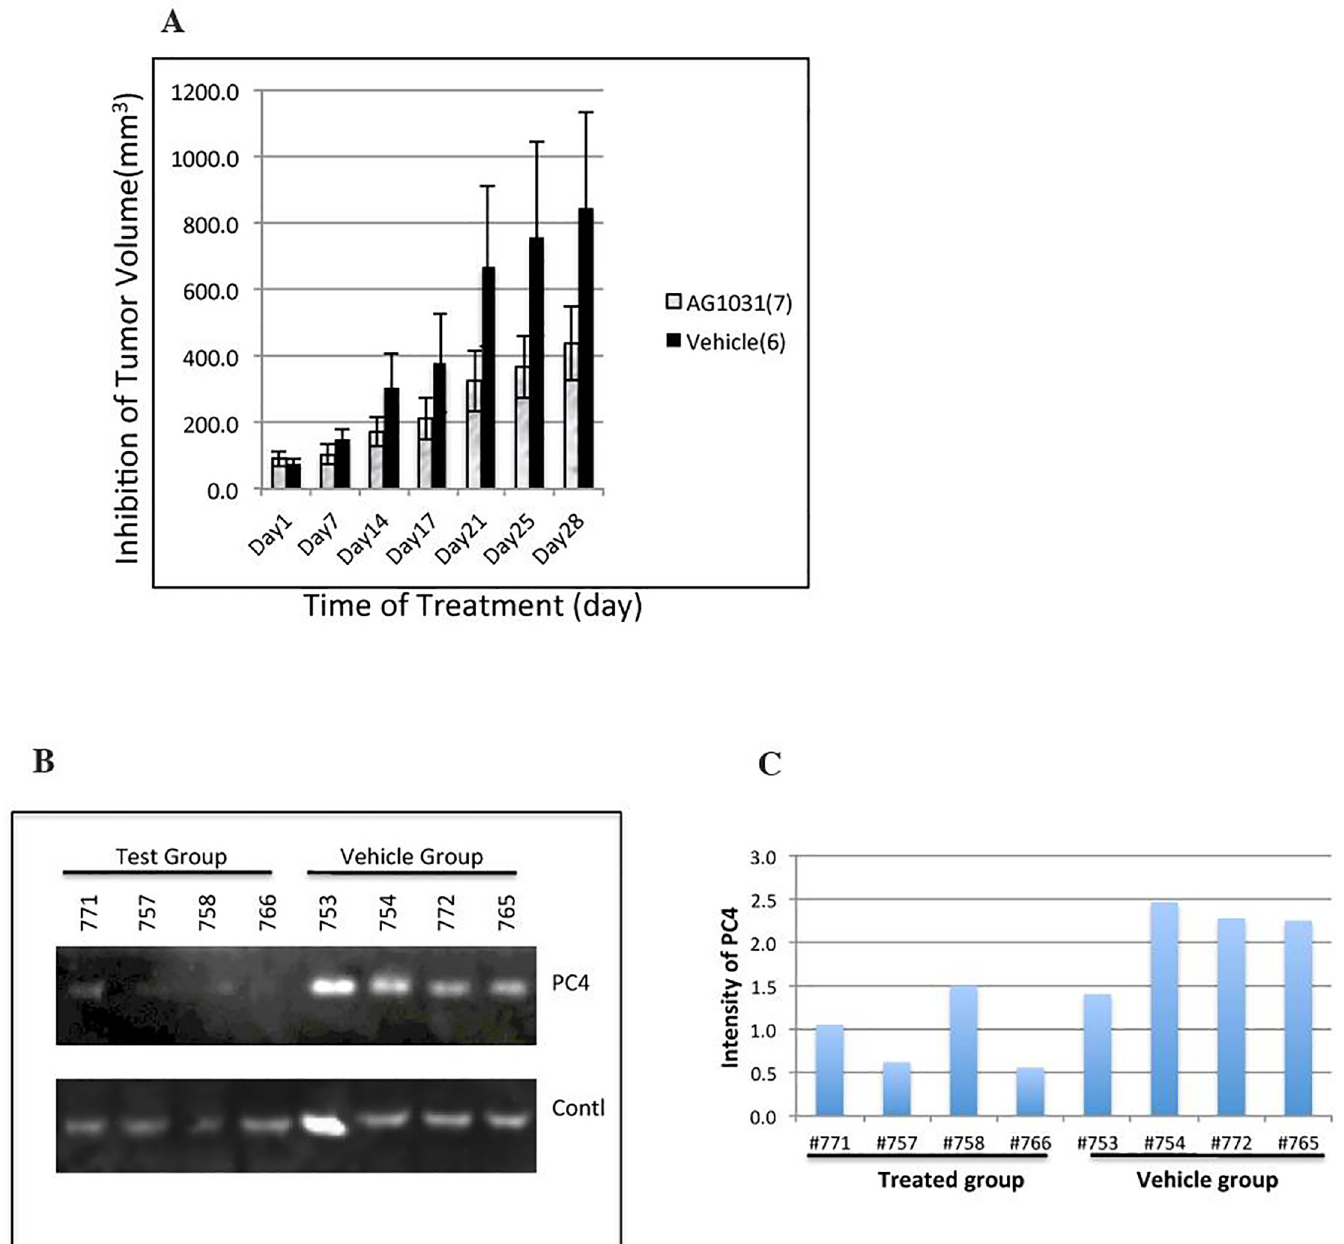
Fig 4. Efficacy of AG-1031 for A549 cell xenografts. A549 cell xenografts were produced in 7 mice and treated with AG-1031 (“AG-1031”) every other day. The tumor size was measured and compared to the control group of 6 mice without AG-1031 treatment (“vehicle”). Panel A compares the average tumor size between treated (“AG-1031”) and untreated (“vehicle”) groups. Western blot analysis revealed a decreased level of PC4 protein in most AG-1031-treated tumor tissues compared to untreated tumor tissues (panel B). Expression of TATA binding protein (TBP) was used as an internal control. The density of PC4 expression was measured and the relative inhibition was plotted (Fig